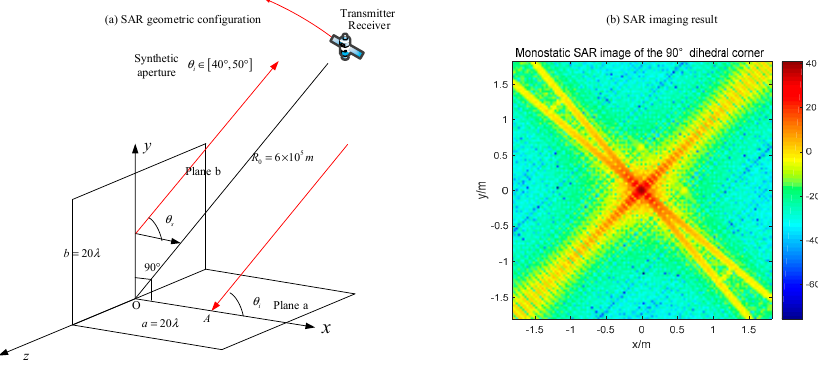
Figure 19. Monostatic image of the orthogonal dihedral corner ( a ) geometric configuration; ( b ) imaging result.